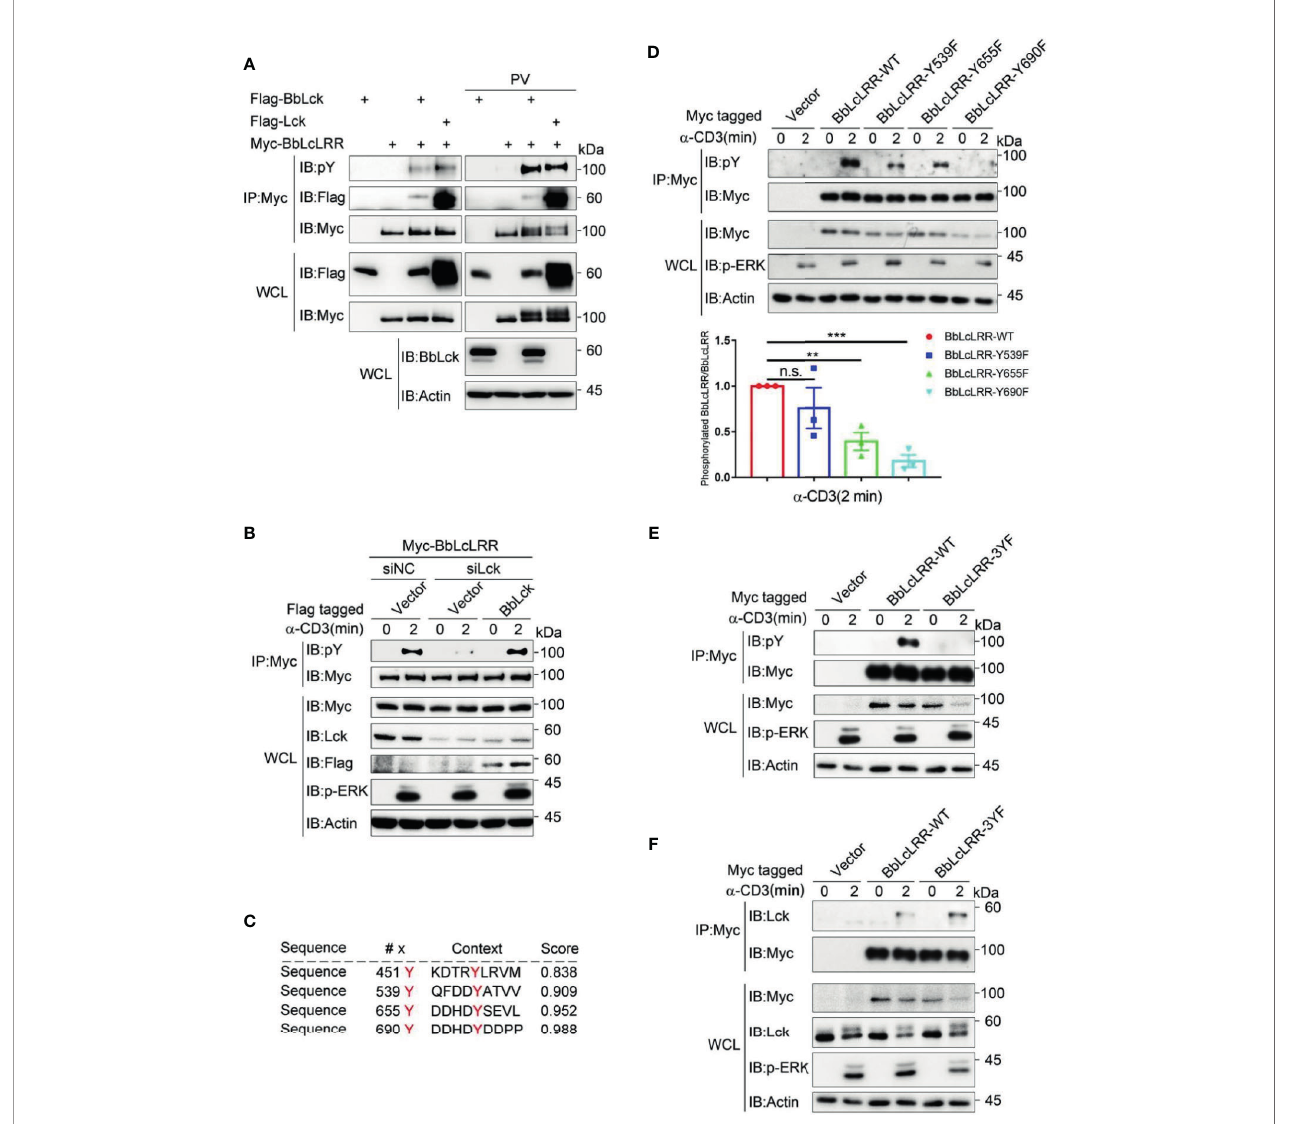
FIGURE 5 | Lck phosphorylates BbLcLRR at multi-tyrosine sites. (A) Both human and amphioxus Lck bind to and phosphorylate BbLcLRR. The indicated plasmids were cotransfected into HEK293T cells, and cell lysates were immunoprecipitated with anti-Myc antibody followed by immunoblotting with the indicated antibodies. PV (pervanadate, phosphatase inhibitors) was used here for detection of tyrosine phosphorylation easily. (B) Knockdown of endogenous Lck reduced TCR-induced BbLcLRR tyrosine phosphorylation, and overexpression of BbLck rescued this reduction. The indicated siRNA and plasmids were cotransfected into Jurkat TAg T cells. After 48 h, the cells were collected and stimulated with anti-CD3 antibody for the indicated times. Cell lysates were immunoprecipitated by anti-Myc antibody, followed by immunoblotting with pY antibody (P-Tyr-100). (C) The tyrosine phosphorylation sites of BbLcLRR were predicted by the NetPhos 2.0 server. (D) The Y539F, Y655F and Y690F mutations decreased TCR-induced tyrosine phosphorylation of BbLcLRR. Cells were transfected with the indicated plasmids. After 48 h of transfection, the cells were treated as in (B) . The densitometric quanti fi cation of the ratio of phosphorylated BbLcLRR to immunoprecipitated BbLcLRR-WT or YF mutants (the ratio for the BbLcLRR-WT was set as 1) is shown on the bottom. (E) The simultaneous Y539F, Y655F and Y690F mutations (3YF) eliminated TCR- induced tyrosine phosphorylation of BbLcLRR. Cells were treated in the same way as in (B) . (F) BbLcLRR and BbLcLRR-3YF interacted with endogenous Lck with different af fi nities. Cells were treated in the same way as in (B) . Cell lysates were immunoprecipitated by anti-Myc antibody, followed by immunoblotting with anti-Lck antibody. n.s., not signi fi cant; ** P < 0.01, and *** P < 0.001 (two-tailed unpaired t -test). The data are presented as the mean (± s.e.m.). Data are representatives of three (B, D, E, F) or two (A) independent